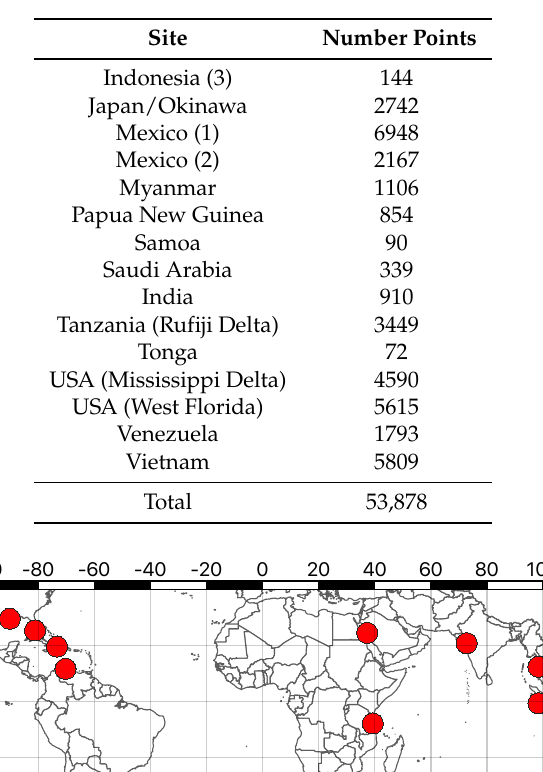
Table 2. Regions where the accuracy assessment was undertaken and the number of accuracy samples which were used.